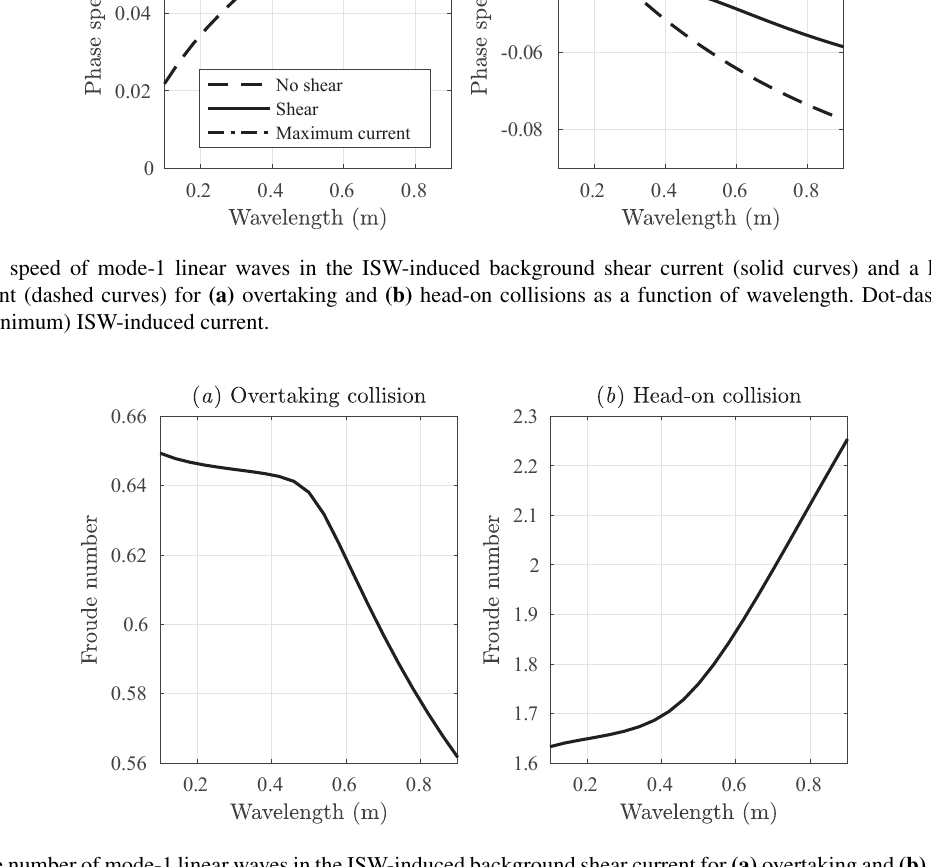
Figure 11. Froude number of mode-1 linear waves in the ISW-induced background shear current for (a) overtaking and (b) head-on collisions as a function of